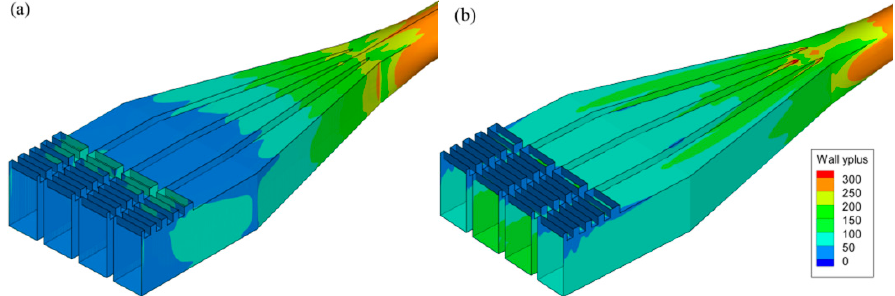
Figure 4. The Distribution of y+ values for the inlet/outlet: ( a ) the inflow condition; ( b ) the outflow condition.